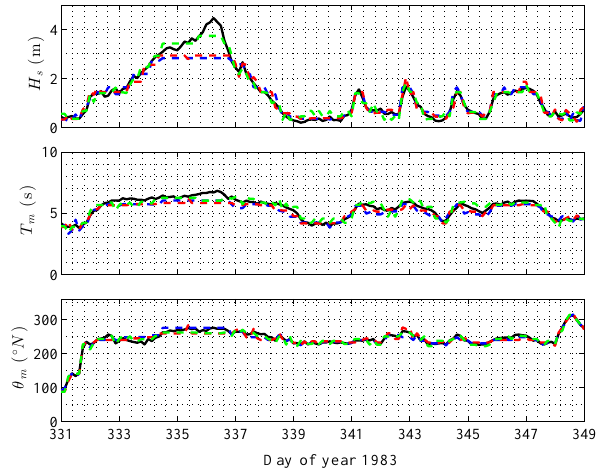
Figure 8. MDA-SOM: comparison between original (black solid lines) and reconstructed time series of H s (top panel), T m (central panel) and θ m (bottom panel), for a chosen sequence of events. Data set reduction: 80% (blue dashed line), 60% (red dashed line) and 10% (green dashed